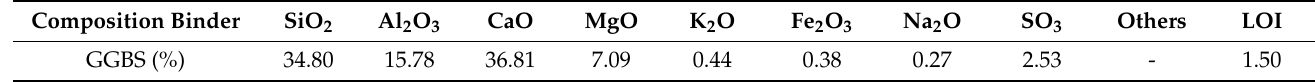
Table 1. Chemical composition of GGBS.